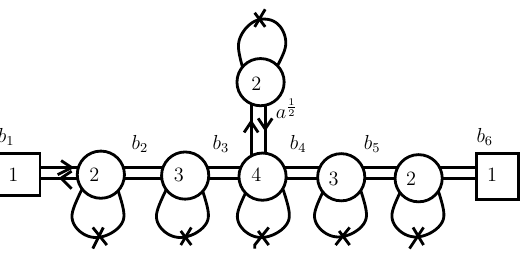
Figure 38 . The quiver for the compacti(cid:12)cation of minimal E 7 conformal matter on torus with (cid:13)ux 1 = 12 to the U(1) corresponding to the central node of one of the two E 7 symmetry factors. The fugacities denote the U(1) symmetries under which the bifundamental (cid:12)elds are charged. As usual all adjoints are charged under an additional U(1) with charge minus one and the bifundamentals are charged 1 =